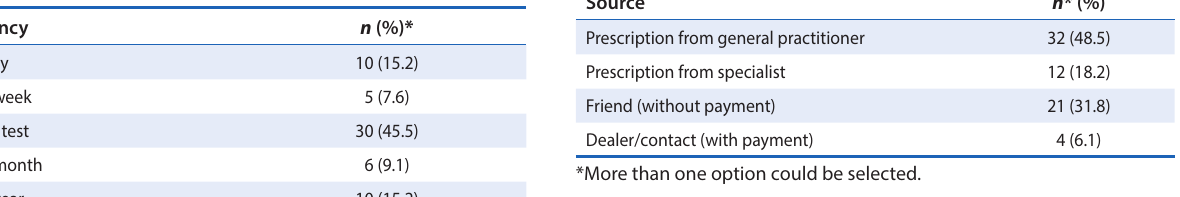
Table 2: Frequency of methylphenidate use among past year users ( n = 66)